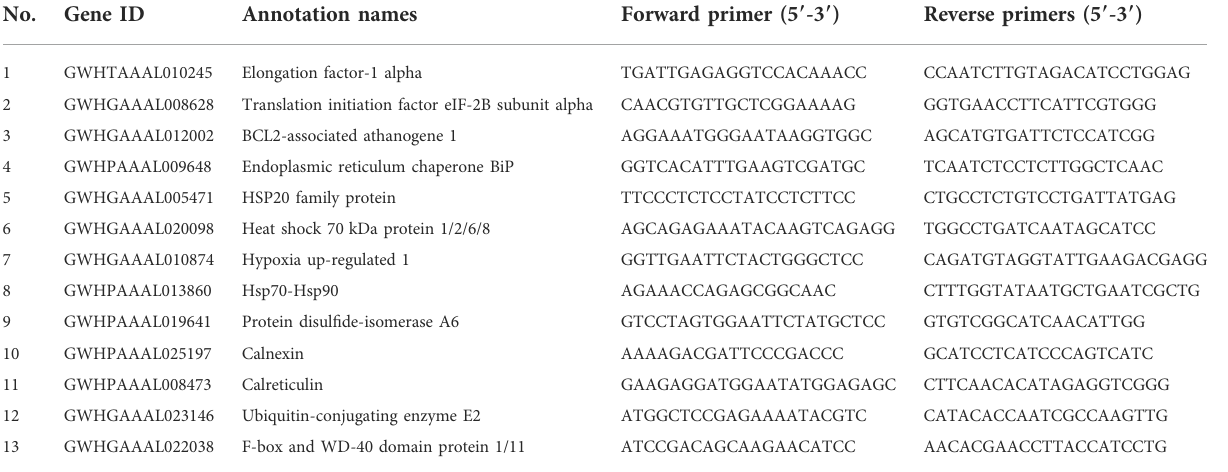
TABLE 1 List of primers used in this study.